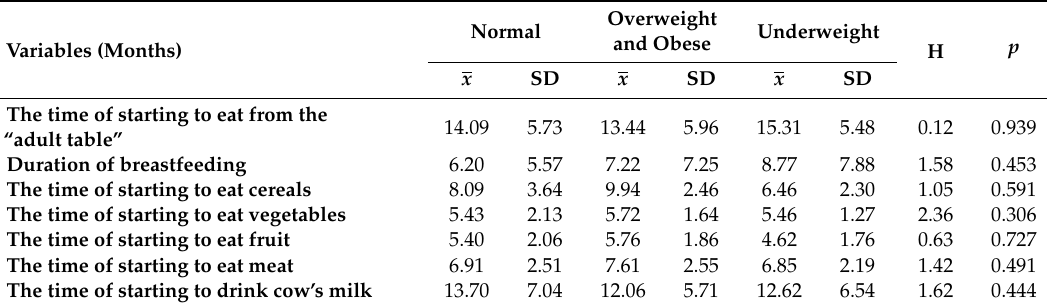
Table 2. Relationship between body weight category and the time of introducing nutritional products and duration of